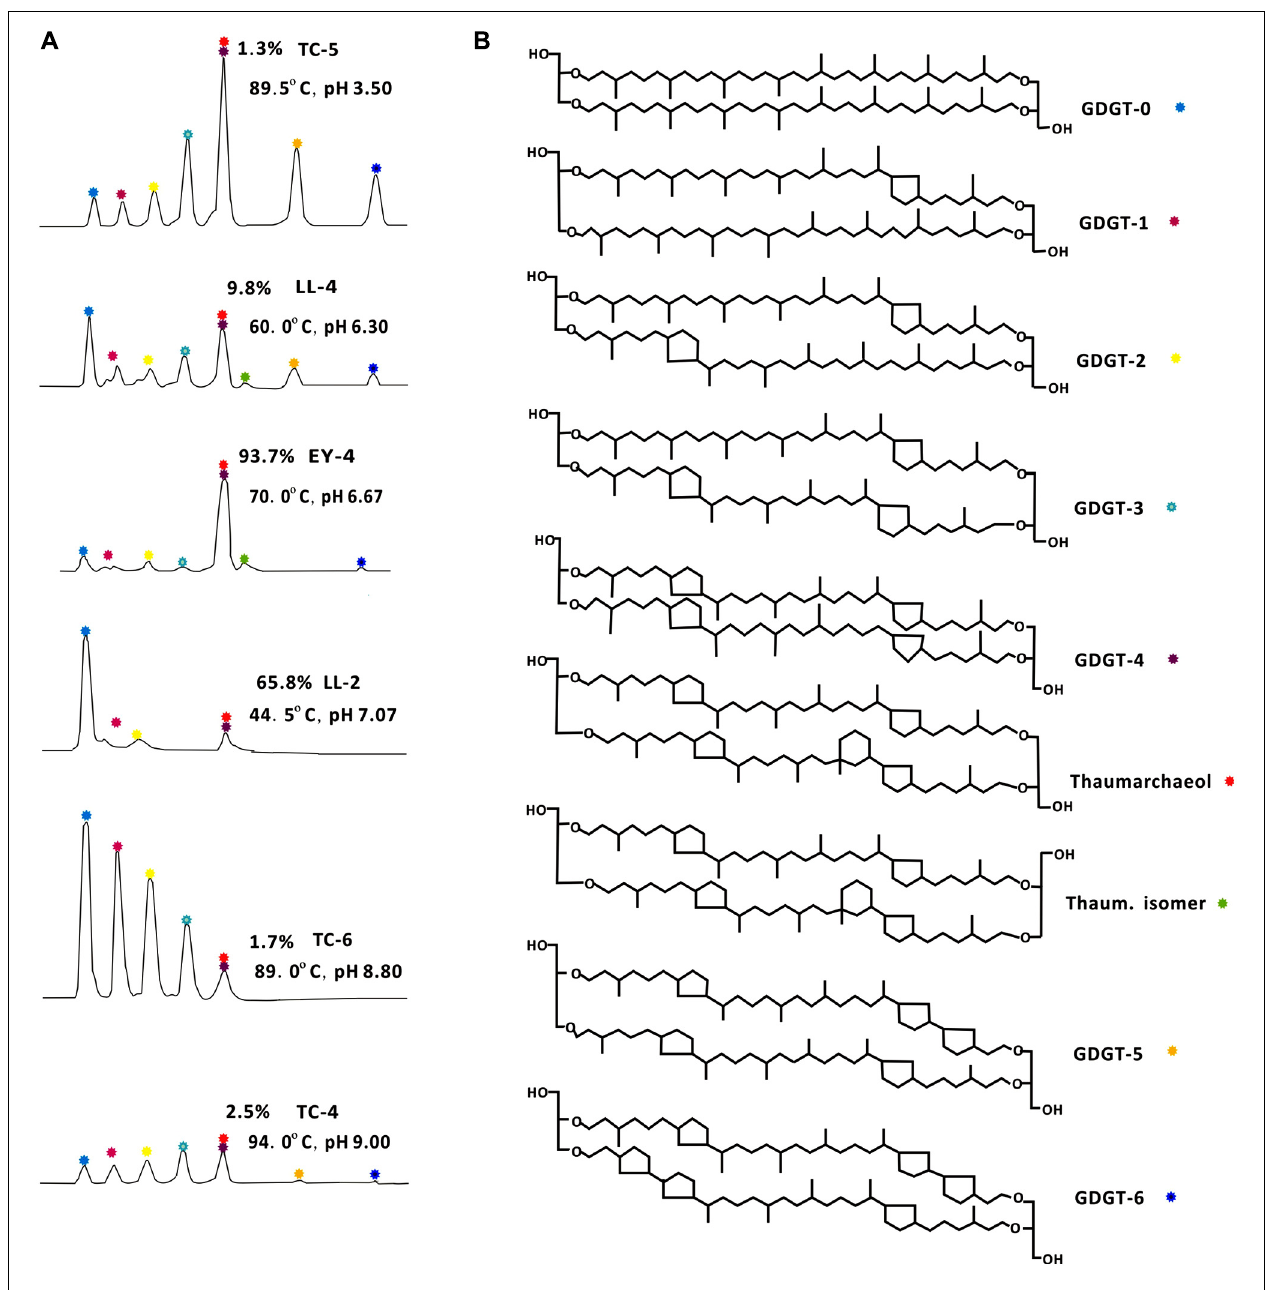
FIGURE 2 | HPLC–APCI–MS base peak chromatograms showing representative distributions of archaeal core lipids with temperature and pH values (A) and chemical structures of GDGTs from Yunnan hot springs (B). TC-5, Zhenzhuquan; LL-4, Banglazhangshangxiao #1;